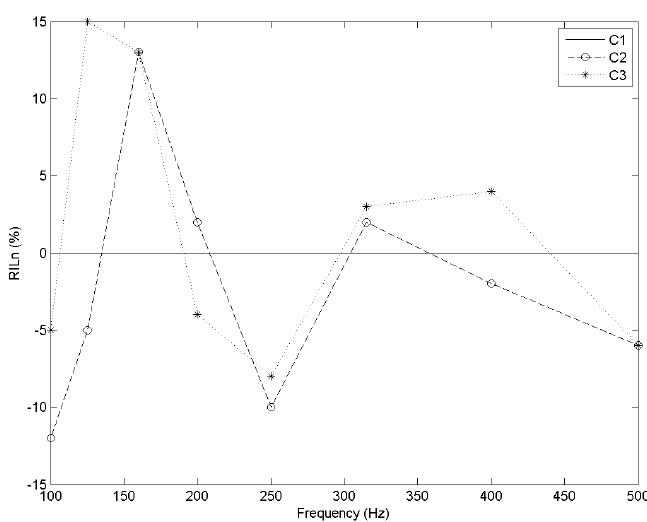
Figure 11. RIL n (%) vs. frequency (Hz) for each cell type. Frequency range 100–500 Hz.